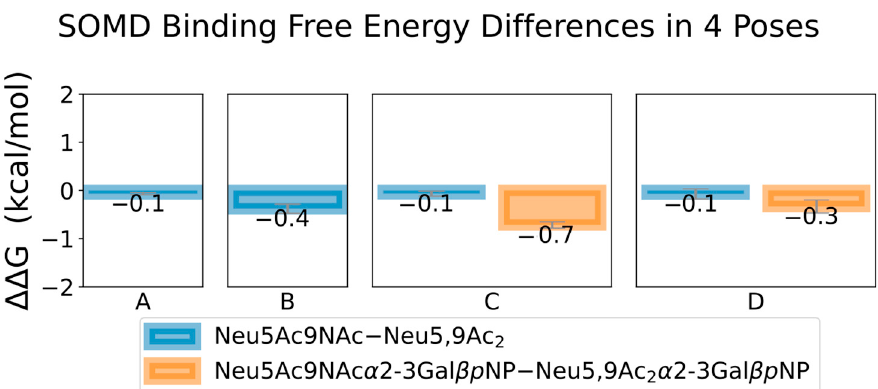
Figure 5. SOMD binding free energy differences for Sias bound in SARS-CoV-2 S protein. Results for transformations between Neu5,9Ac 2 and Neu5Ac9NAc shown for poses ( A – D ), and between Neu5,9Ac 2 α 2-3Gal β p NP and Neu5Ac9NAc α 2-3Gal β p NP shown for poses c and d. Error bars are plotted from standard error of means across 4 simulations, when available. See Figure S4 for all SOMD results, including Neu5Ac and Neu5Ac α 2-3Gal β p NP), and Figure S5 for MM-PBSA energies and energy decomposition results.